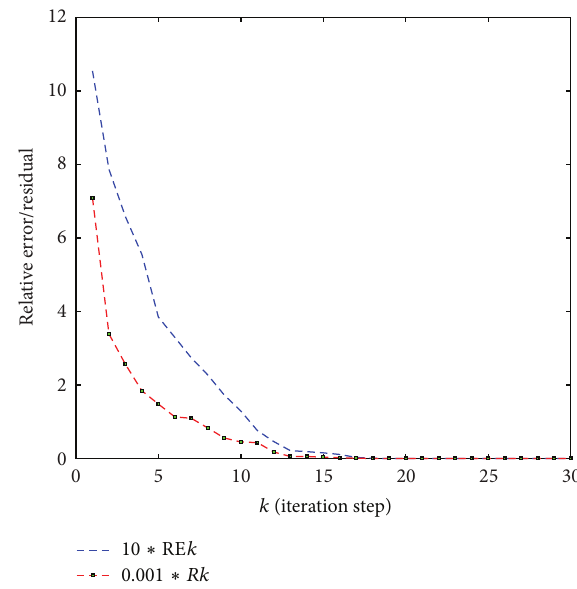
Figure 2: The relative error of the solutions and the residual for Example 10 with 𝑋 0 1 and 𝑋 0 2